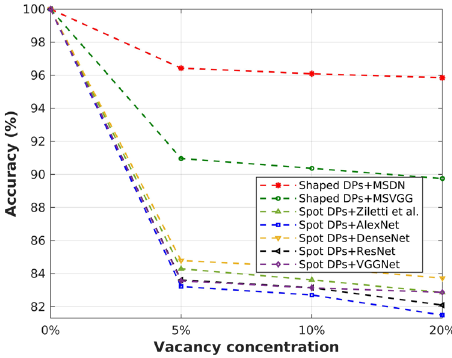
Fig. 9 Robustness of our model to defects. Classi fi cation accuracy as a function of vacancy concentrations. The experiment was performed using only test samples that were classi fi ed correctly in non-defect cases, which agrees with 100% accuracy for the 0% defect concentration case for all